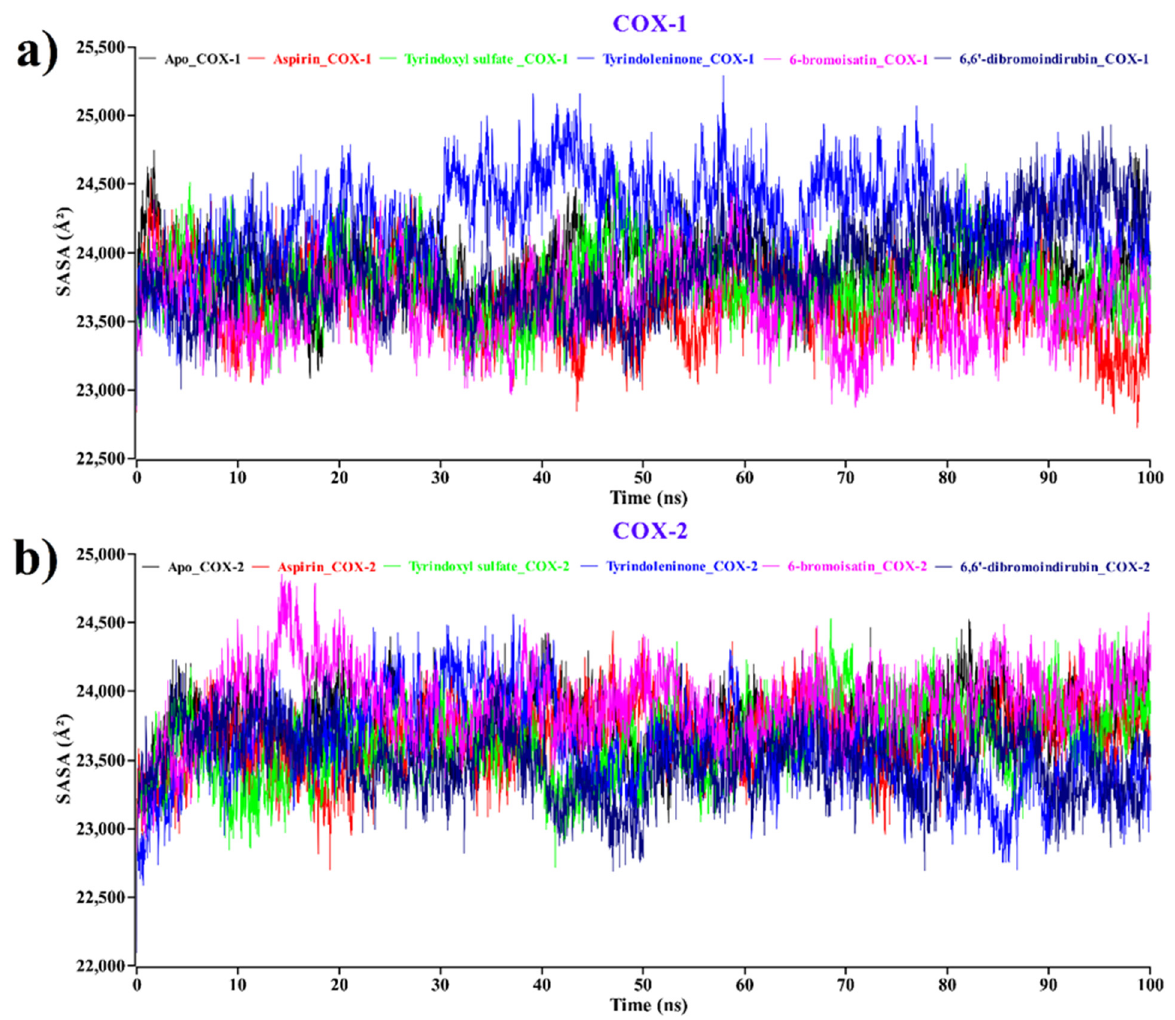
Figure 6. Time evolution of SASA for the protein of each docked complex for ( a ) COX-1 and ( b ) COX-2. Complexes: black—apo protein, red—aspirin, green—tyrindoxyl sulfate, blue—tyrindoleninone, magenta—6-bromoisatin, navy blue—6,6’- dibromoindirubin.